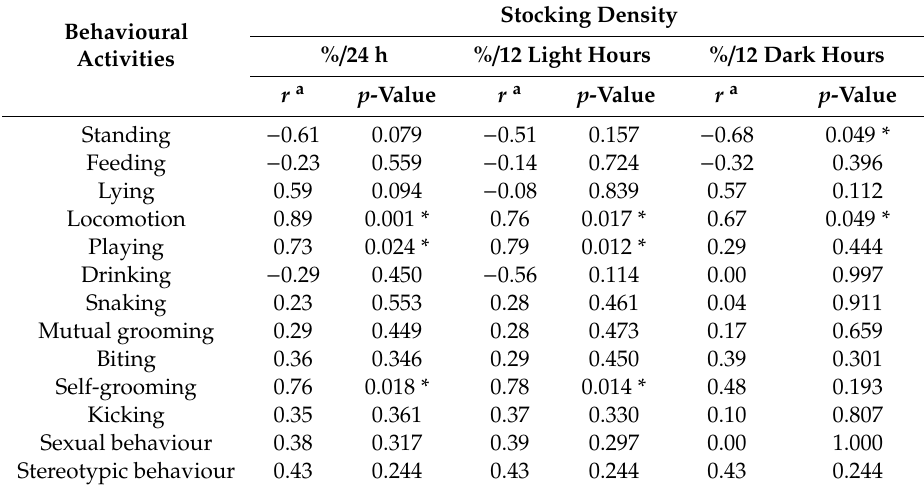
Table 3. Associations between the time-budgets (% / 24 h; % / 12 light hours; % / 12 night hours) and stocking densities among the group pens.